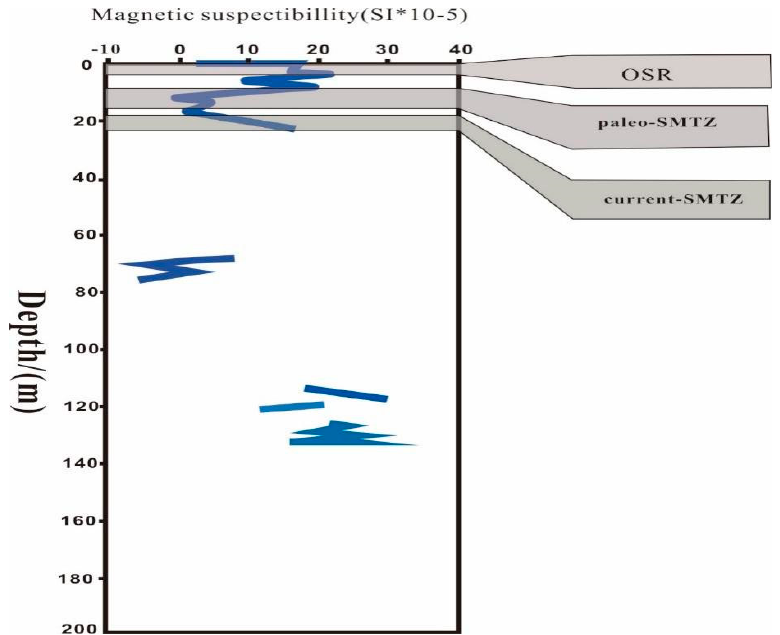
Figure 4. A graph of the change in magnetic properties with depth. The areas marked from top to bottom are OSR, paleo-SMTZ, and current-SMTZ. The magnetic drop in the paleo-SMTZ is obvious, but there was no significant drop in current-SMTZ magnetism. The magnetic data comes from the report of GMGS1: Measuring the Concentration, Nature, and Distribution of Gas Hydrate.